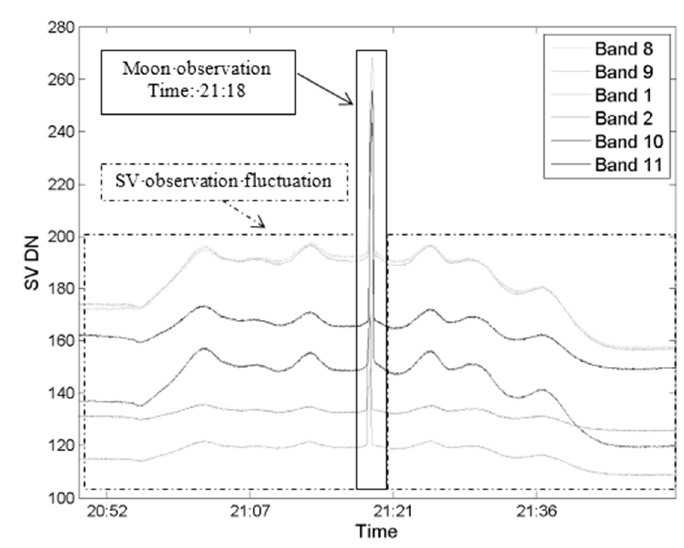
Figure 6. S pace view (SV) data around the lunar observation (29 December 2017). Figure 6. Space view (SV) data around the lunar observation (29 December